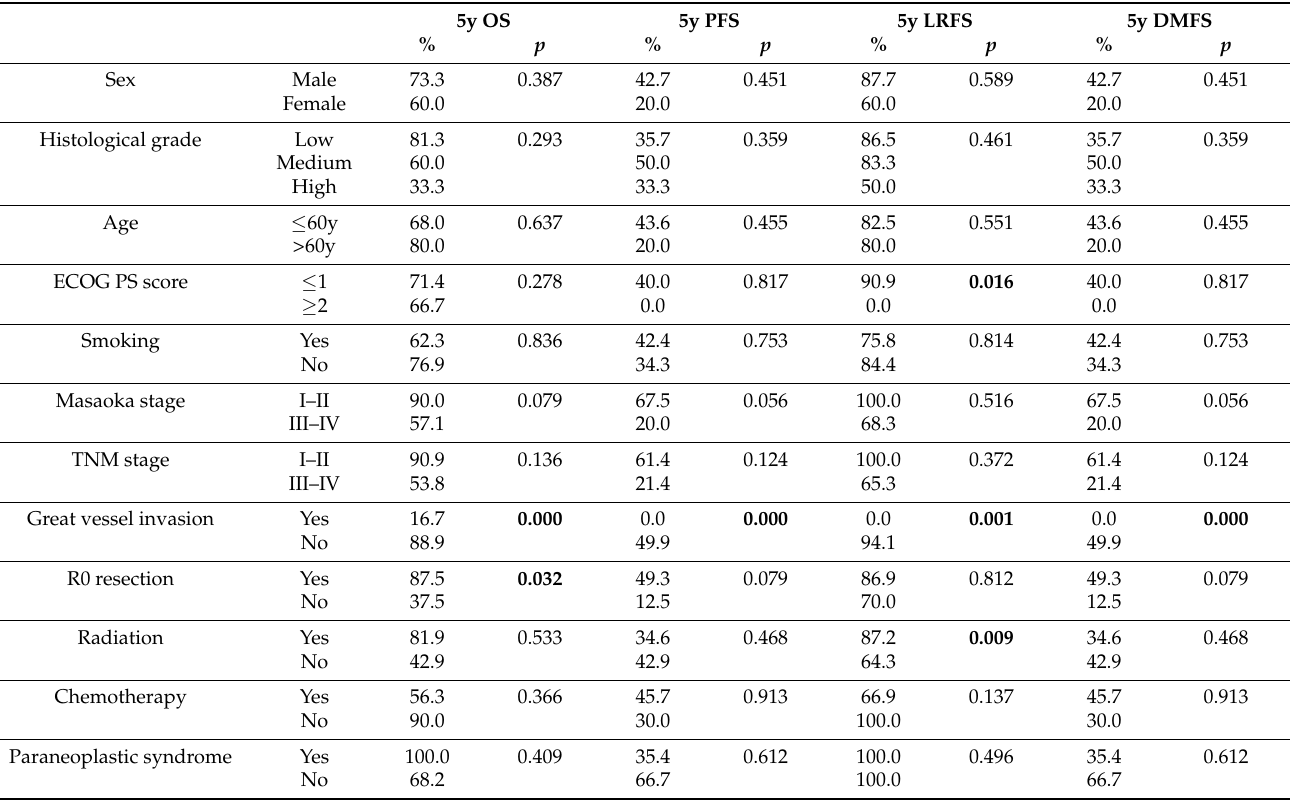
Table 3. Univariate analysis of